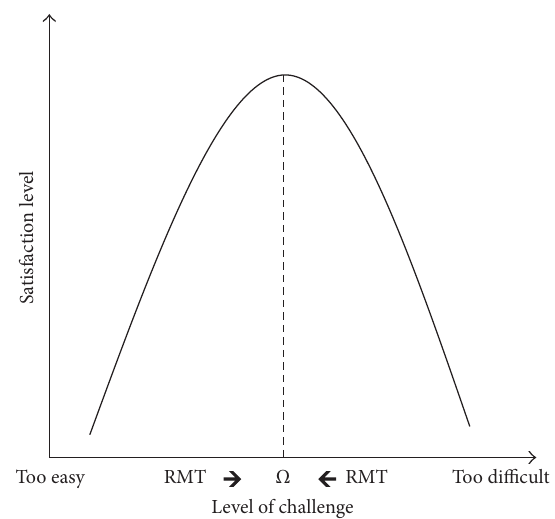
Figure 2: RMT influence on the satisfaction of the player [3].